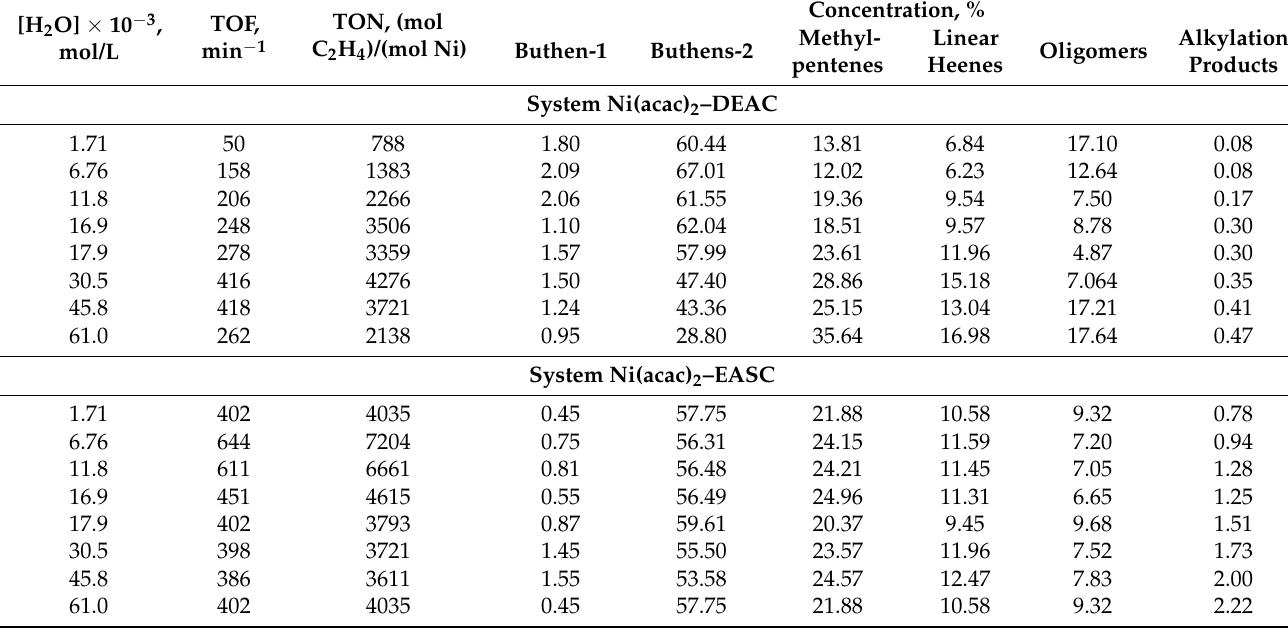
Table 4. Dependence of the products composition formed in the ethylene oligomerization and toluene alkylation (toluene + alkylation products = 100%) in the presence of catalytic systems Ni(acac) 2 –50DEAC and Ni(acac) 2 –EASC on the concentration of water in toluene: C Ni = 2.5 × 10 − 3 mol/L, T = 285 K, the solvent is toluene. Data were taken from ref.